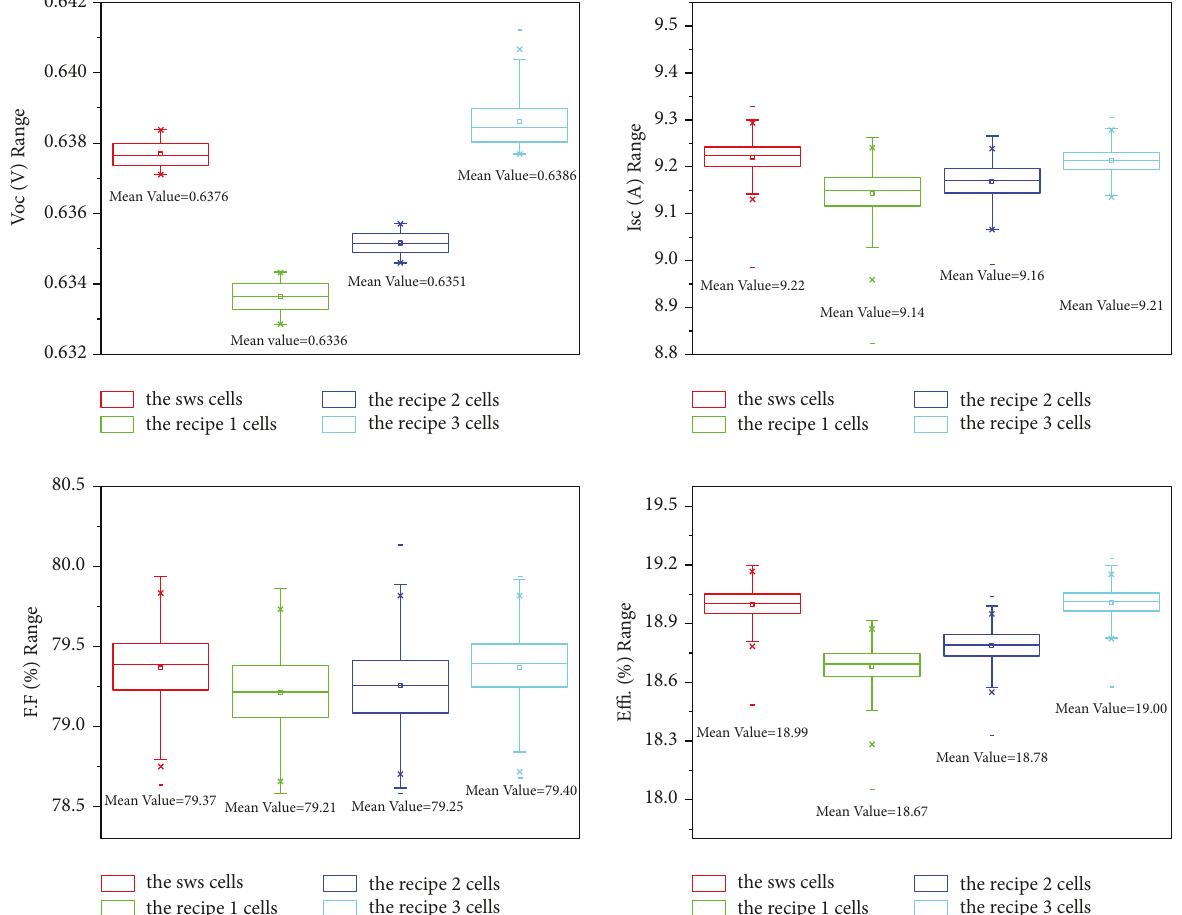
Figure 7: Electrical performance parameters of the solar cells with different texturing processes.